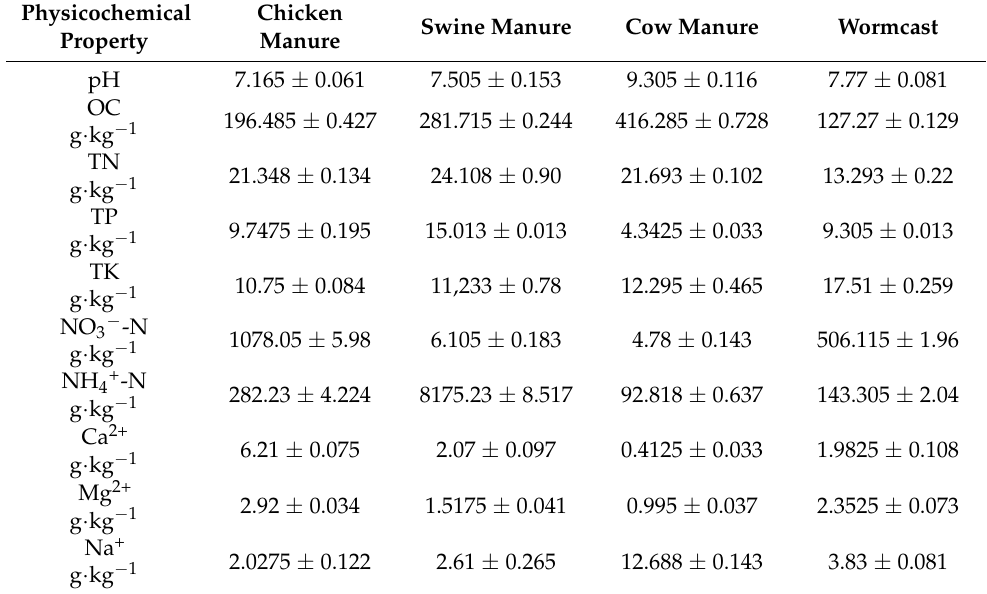
Table 1. Physicochemical characteristics of the four types of compost manures. OC, organic carbon; TN, total nitrogen; TP, total phosphorus; TK, total potassium; NO 3 − -N, nitrate nitrogen; NH 4 − -N, ammonium nitrogen; Ca 2+ , Calcium ions; Mg 2+ , Magnesium ions; Na + , Sodium ions. CM, chicken manure; SM, swine manure; CD, Cow dung; WC,